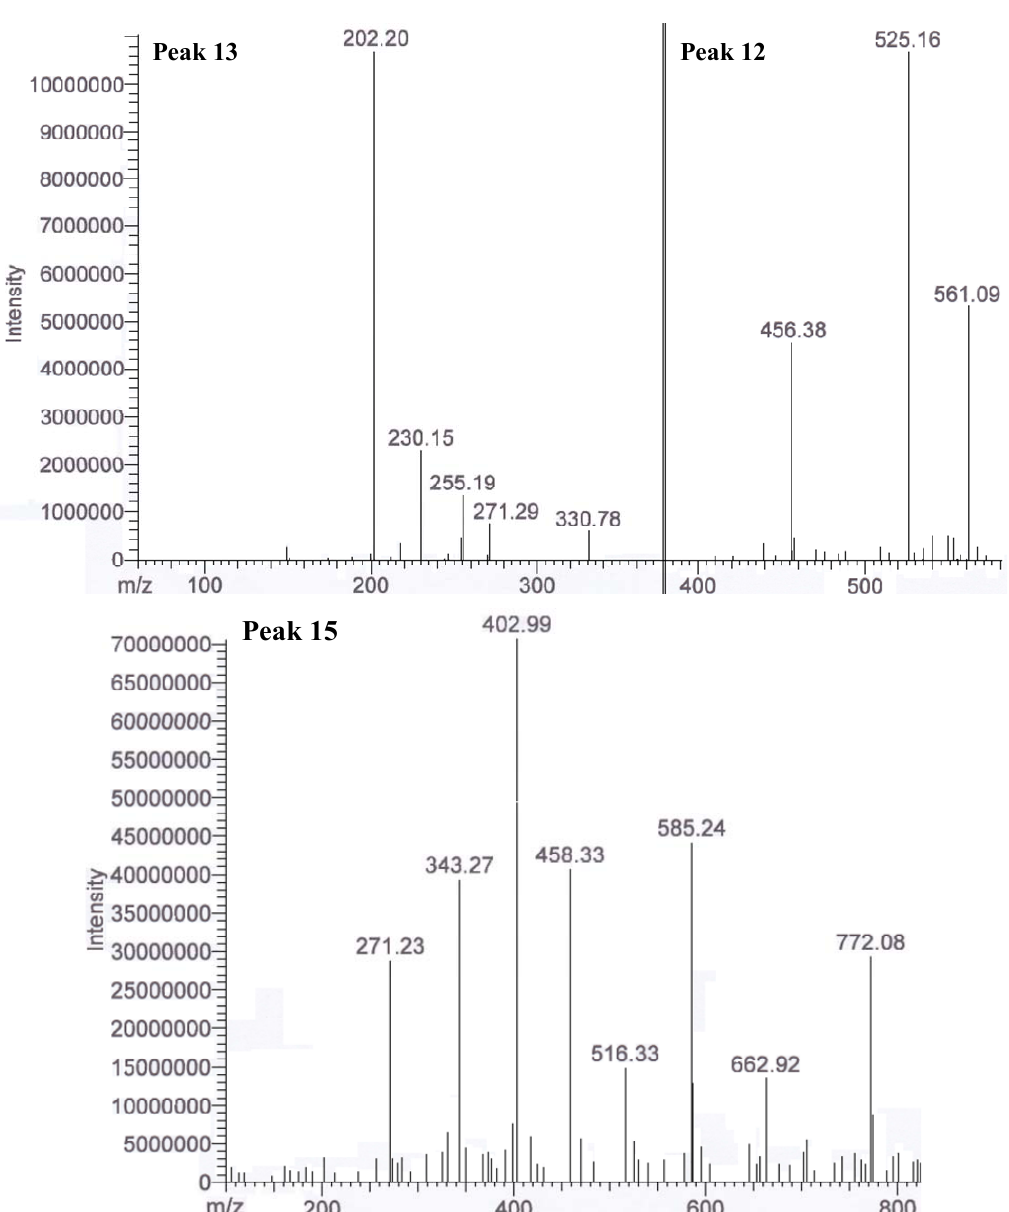
Figure 4. MS/MS of peaks 12, 13 and 15 (unknown compounds) in the extract of part of a defatted dabai